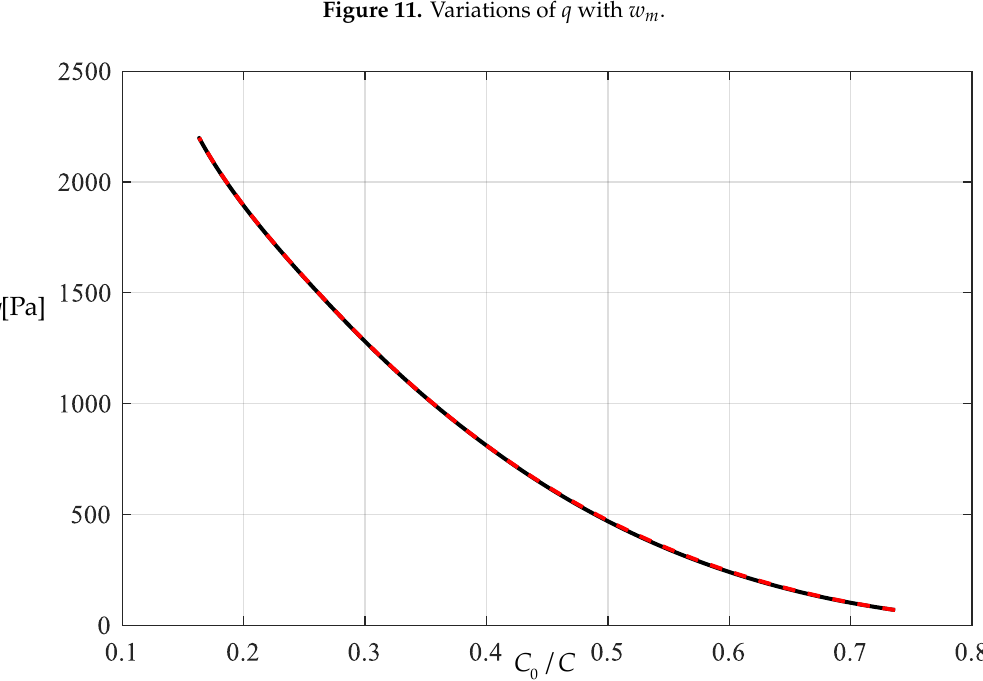
Figure 12. Variations of q with C 0 / C .